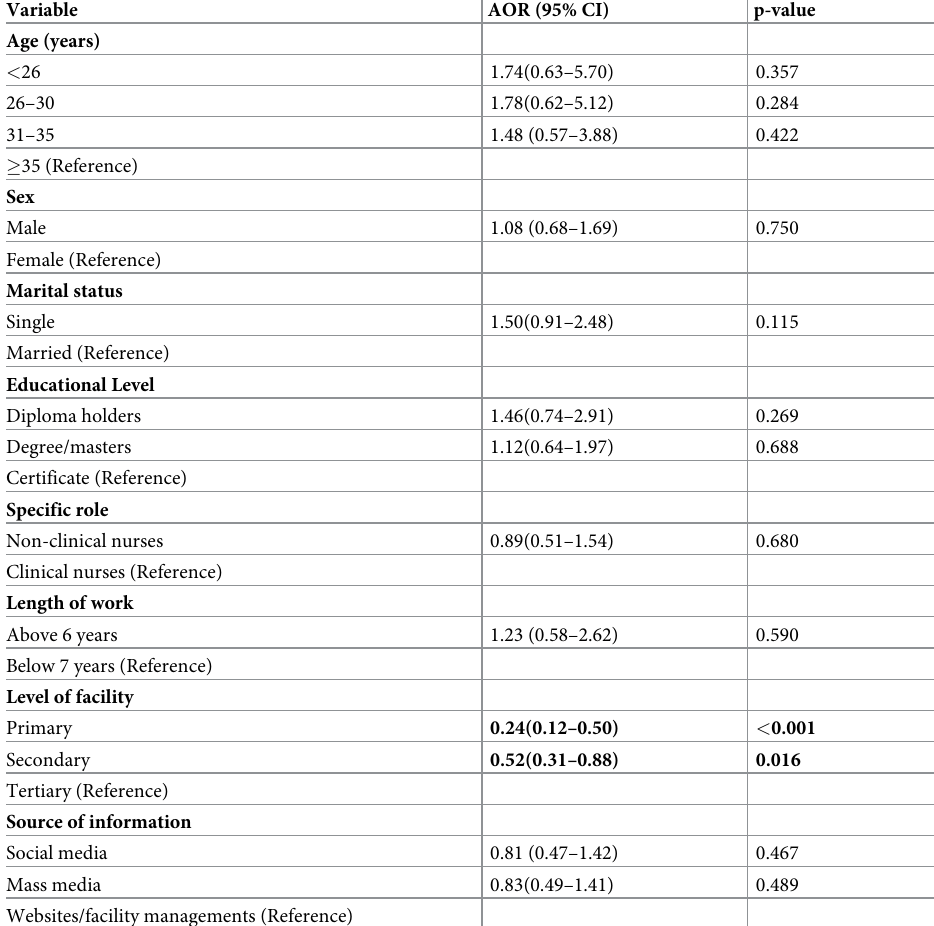
Table 3. Factors associated with nurses’ level of adherence to COVID-19 safety protocols at health facilities in Tamale Metropolis, Ghana (n =